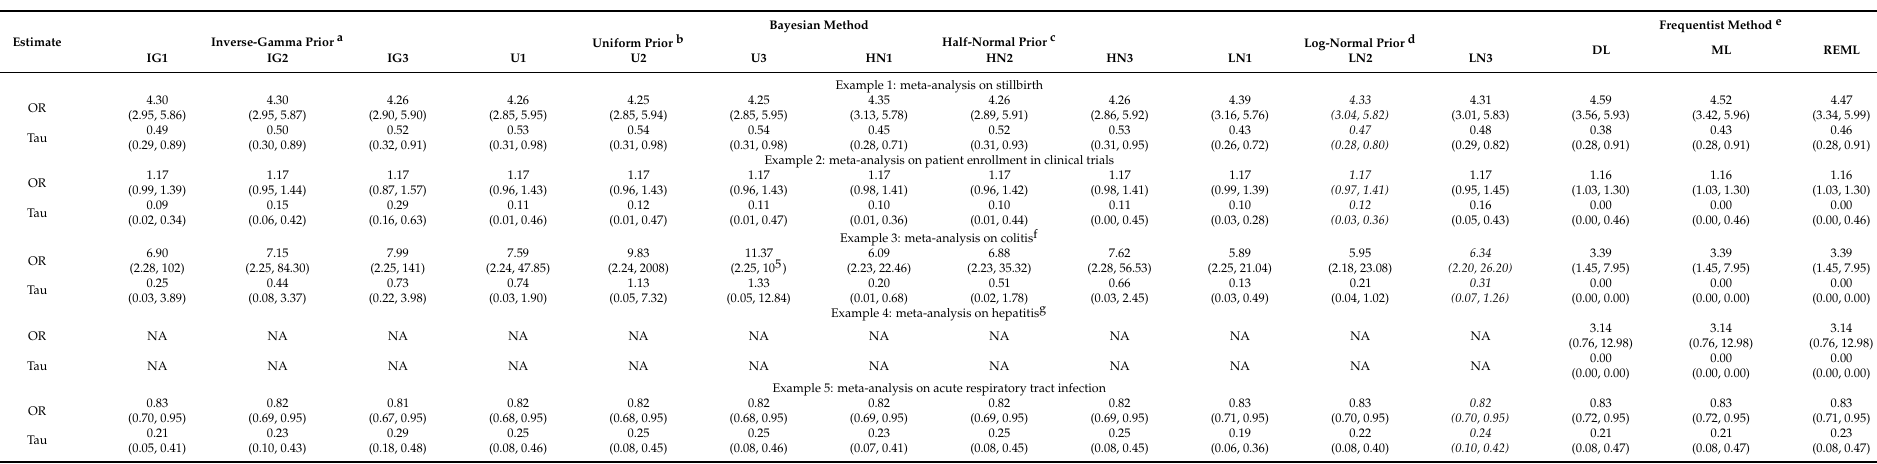
Table 2. The estimated odds ratios (OR) and heterogeneity standard deviations (Tau) with their 95% credible/confidence intervals using different methods in the five examples. BayesianMethod FrequentistMethode Estimate Inverse-GammaPriora UniformPriorb Half-NormalPriorc